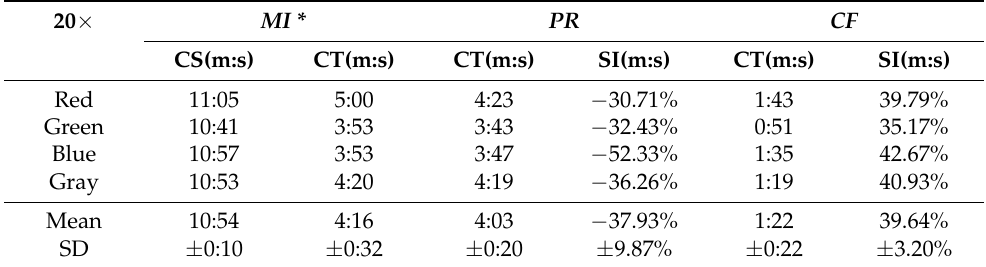
Table 3. CS, CT and SI for mean intensity MI* , plasma reduction PR and clot formation CF ∗ in the 20.